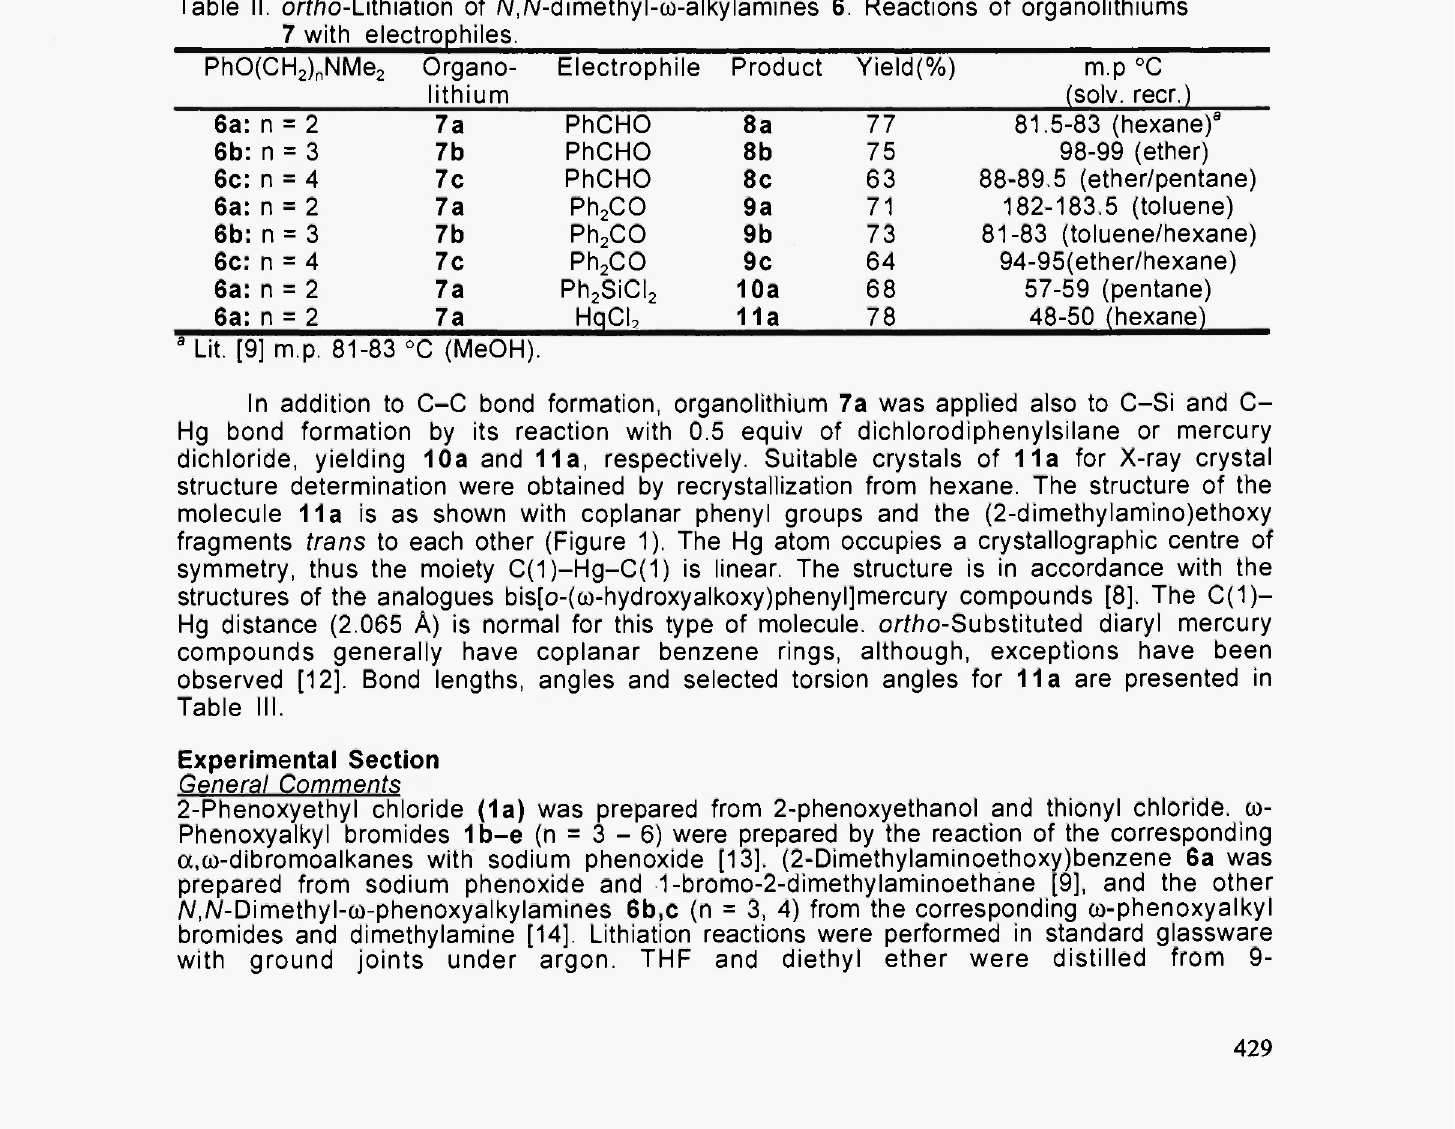
Table II. orfho-Lithiation of /S/./V-dimethyl-w-alkylamines 6. Reactions of organolithiums 7 with